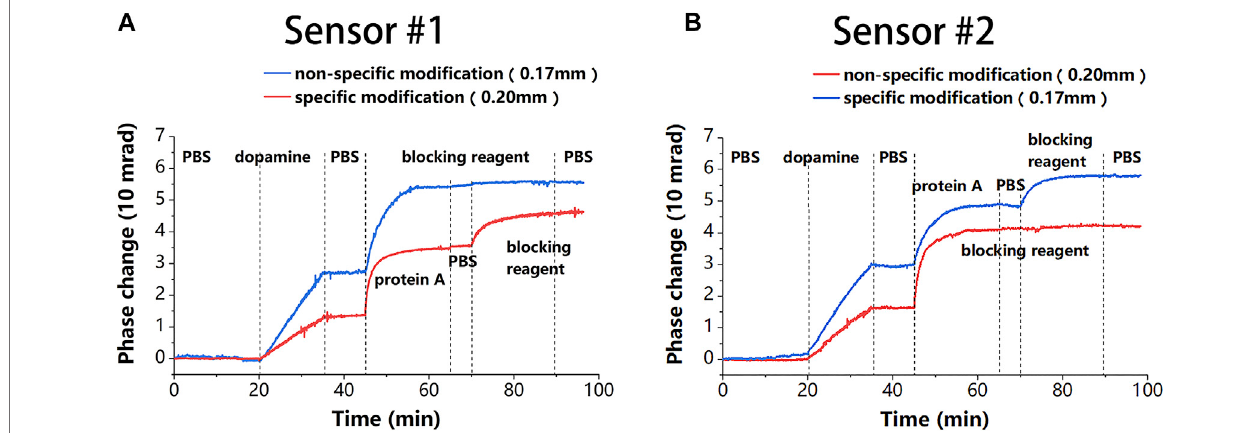
FIGURE 5 | The modi fi cation results of the two sensors, where the blue line corresponds to the 0.17-mm chip and the red line corresponds to the 0.20-mm chip. (A) The modi fi cation result of sensor #1, where a 0.20-mm chip is used for speci fi c binding and a 0.17-mm chip for non-speci fi c binding. (B) The modi fi cation result of sensor #2, where a 0.17-mm chip is used for speci fi c binding and a 0.20-mm chip for non-speci fi c binding.